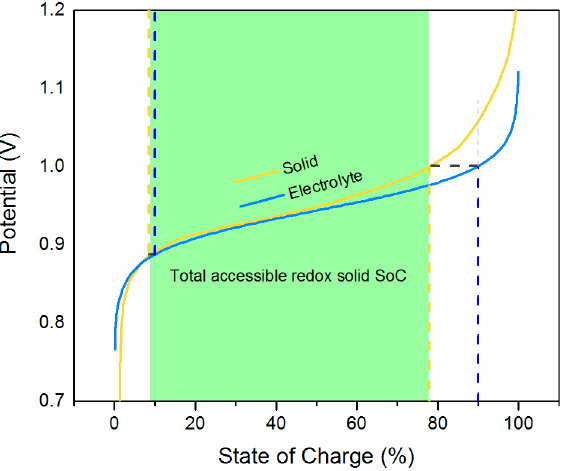
Figure 2. Accessible SoC of solid booster as a function of electrolyte potential with matching standard potentials.